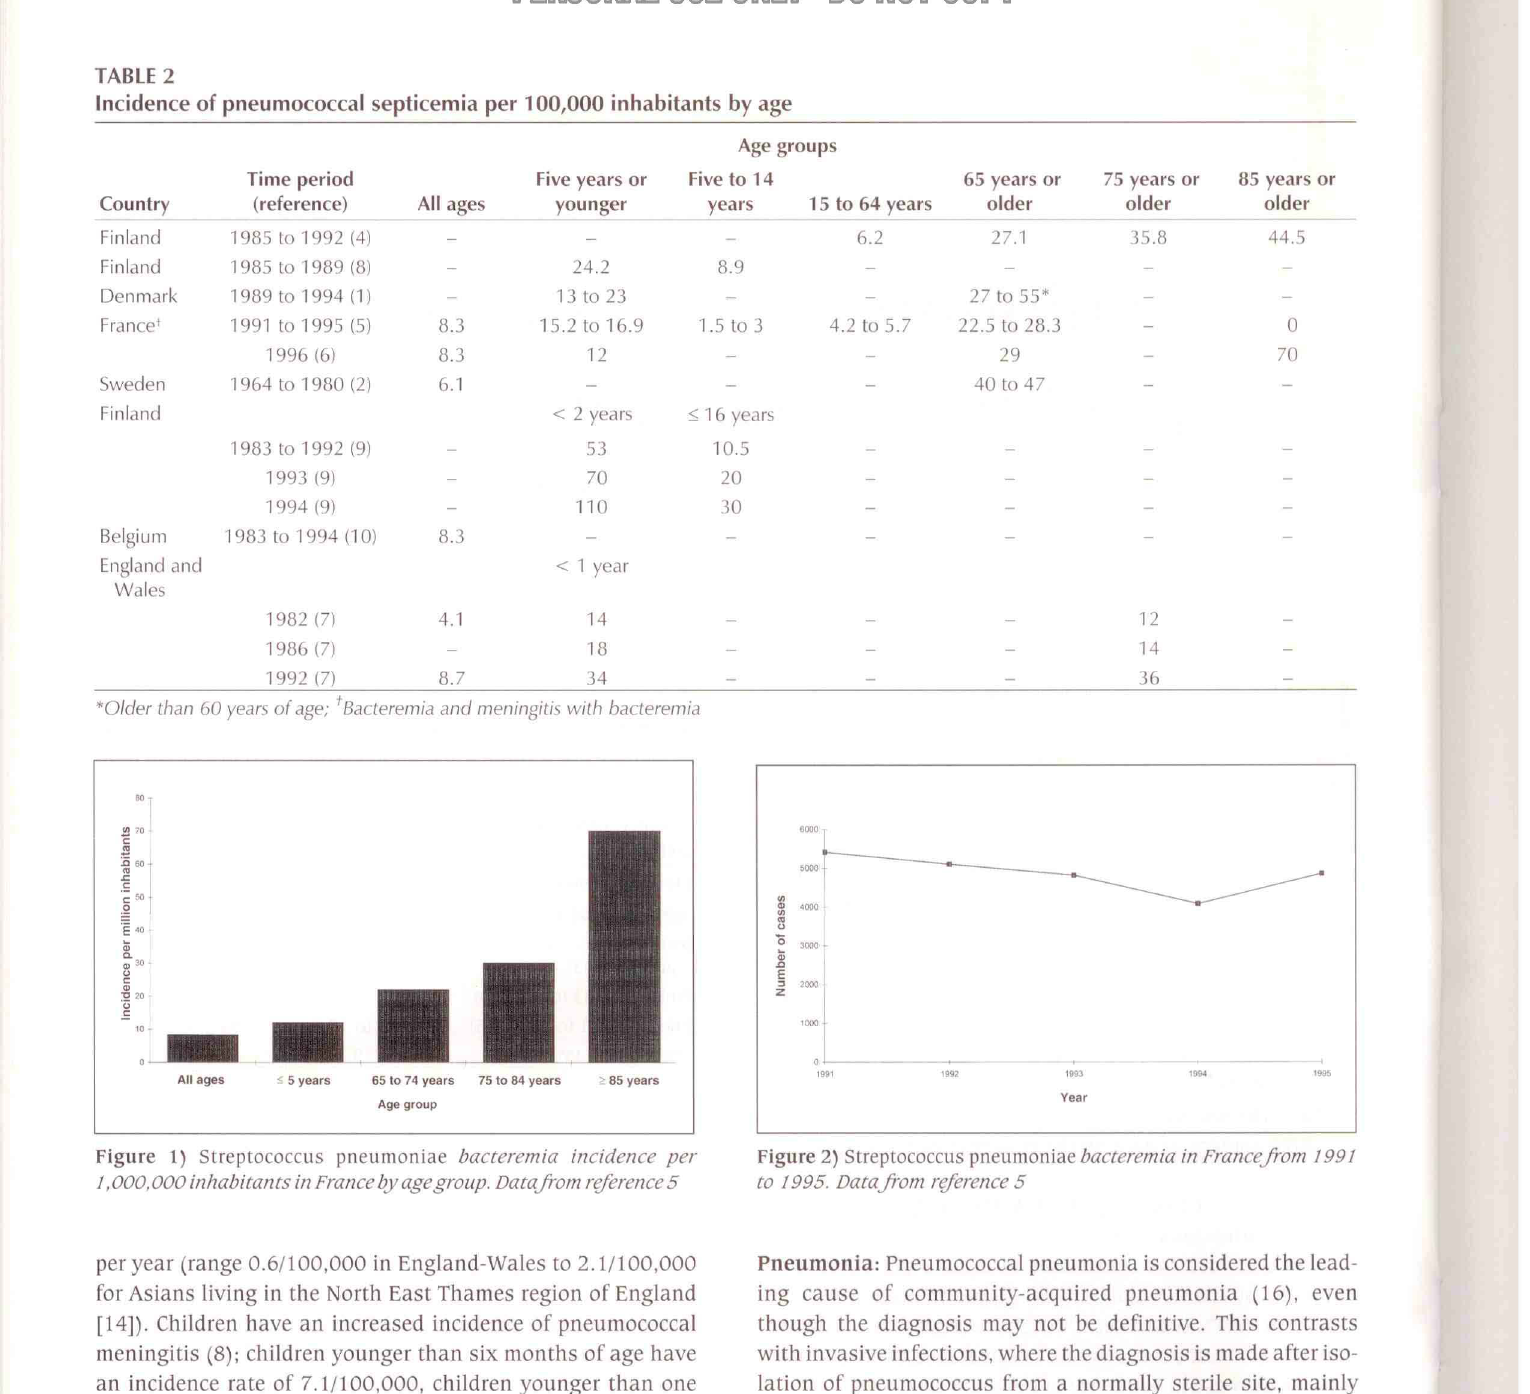
Figure 2) Streptococcus pneumoniae bacteremia in FranceJrom 199 l to 1995. DataJrom reference